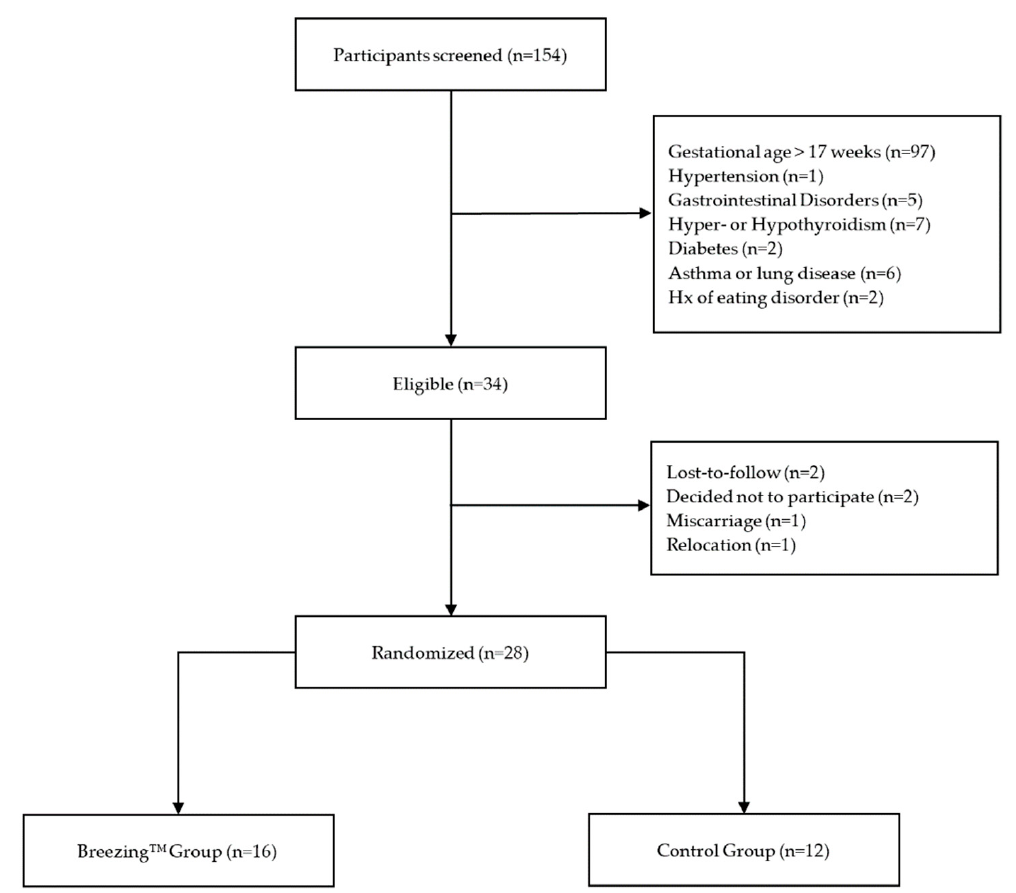
Figure 1. Study Consort Diagram.